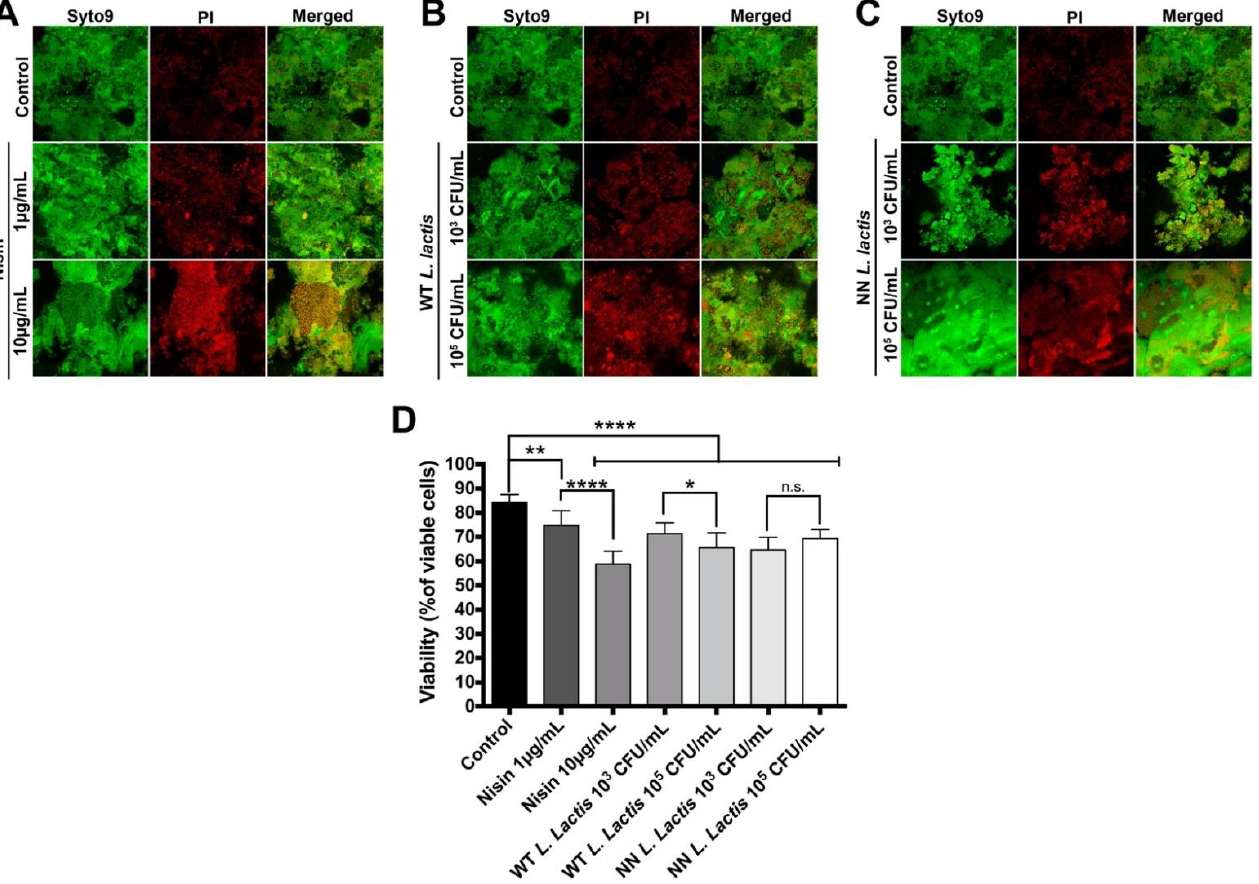
Figure 2. Nisin effectively disrupts oral biofilms on Laser-Lok ® grade V titanium discs. Biofilms were treated with either nisin ( A ), WT L. lactis ( B ) or NN L. lactis ( C ) for 24 h. ( A – C ) Representative images of fluorescently labeled biofilms are shown. The columns, from left to right, represent the different staining dyes/protocols; SYTO9 is a live cell stain, whereas propidium iodide (PI) is a dead-cell stain, and the merged image shows the overlap of both stains. The rows represent the different treatments. ( D ) Quantification of the bacterial viability assessed from the confocal images is shown. n.s. means not significant; * means p ≤ 0.05; ** means p ≤ 0.01; and **** means p ≤ 0.0001 between the marked samples.